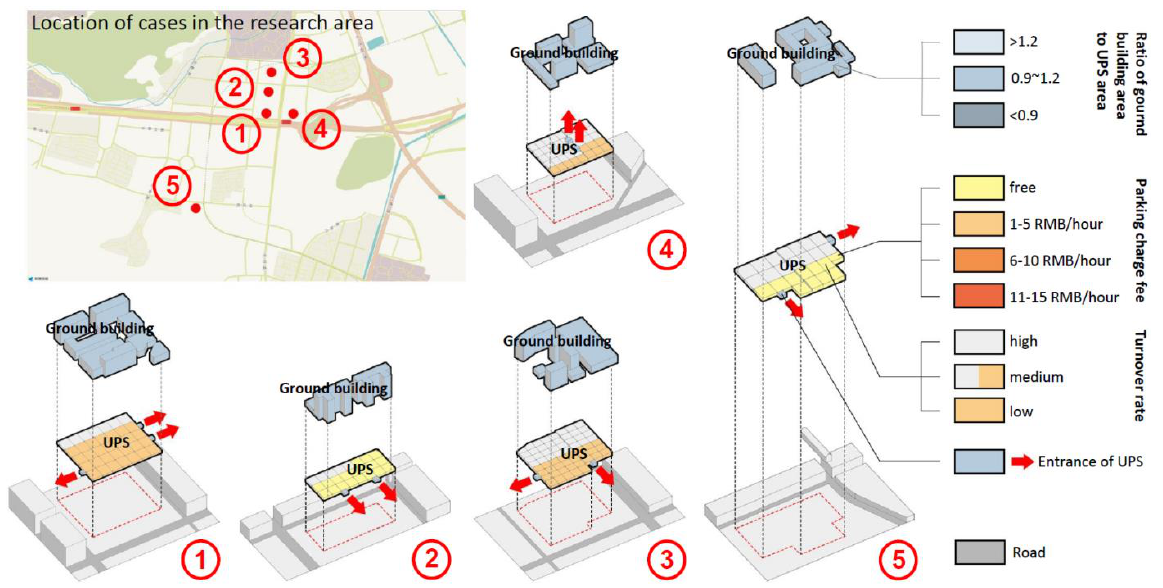
Figure 3. Analysis diagram of UPSs.